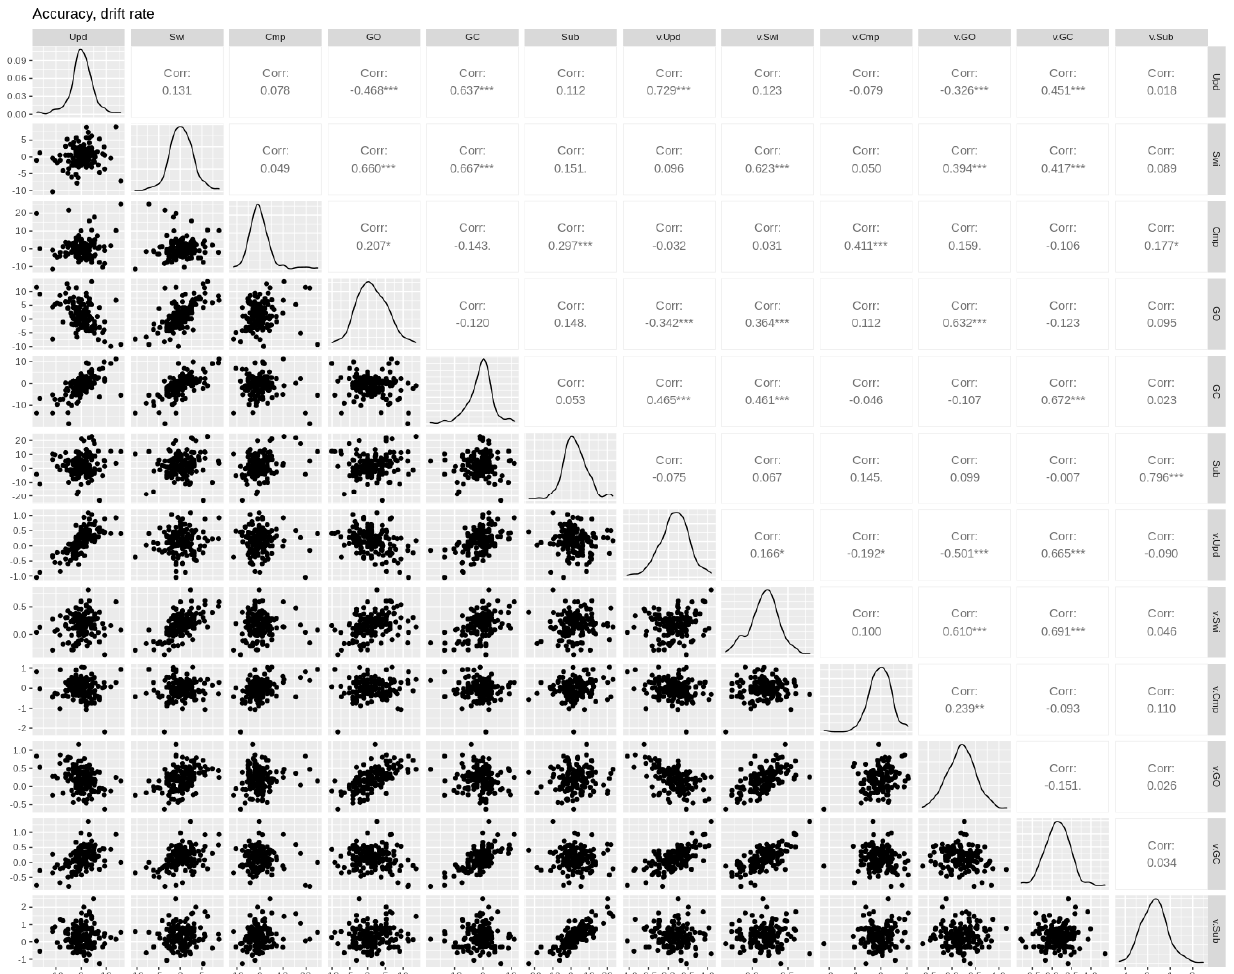
Figure A2. Pairwise Pearson correlations between drift rate and accuracy cost effects. Empirical effects are shown in the first six columns. Parameter effects are shown in the last six columns (prefixed with the parameter name). Upd = updating, Swi = switching, Cmp = comparison, GO = gate opening, GC = gate closing, Sub = substitution. Asterisks *, **, and *** denote p ‐ values of <0.05, <0.01, and <0.001, respectively.